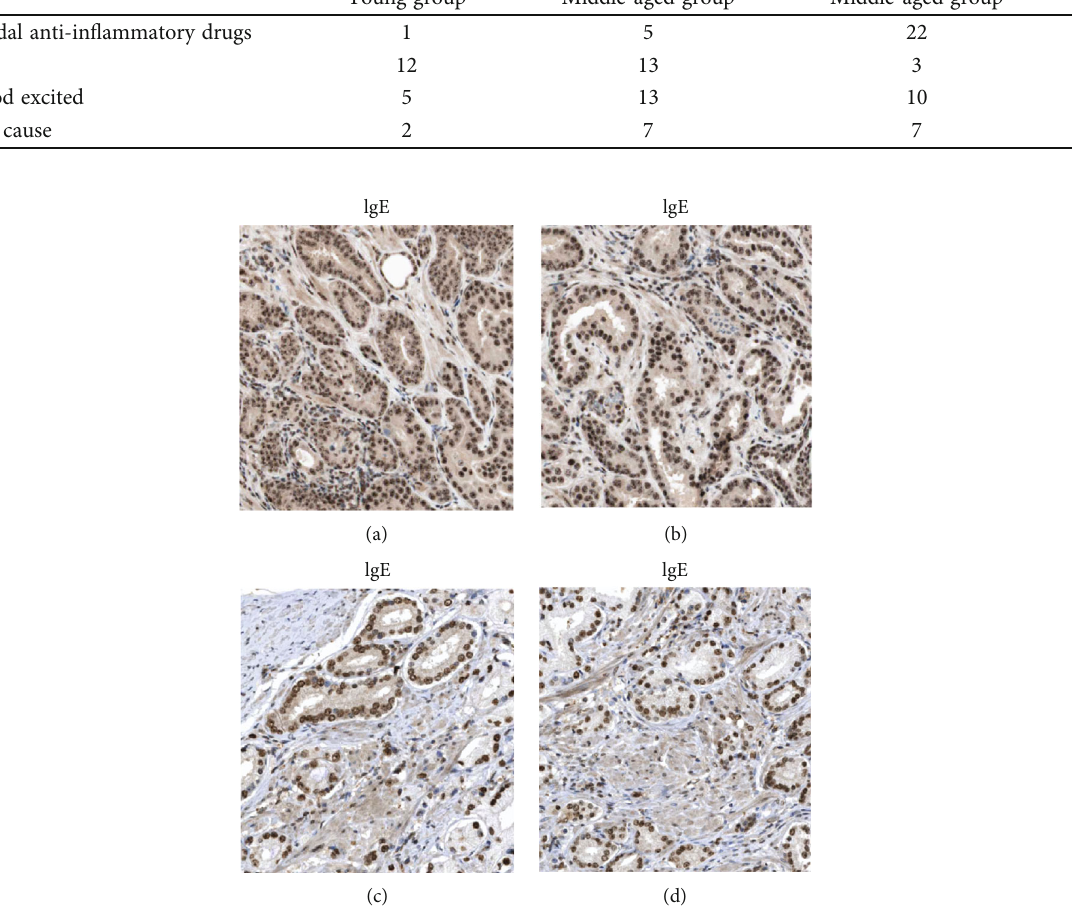
Figure 1: Immunohistochemistry of human upper gastrointestinal ulcer tissue (histological staining and immunohistochemical staining of